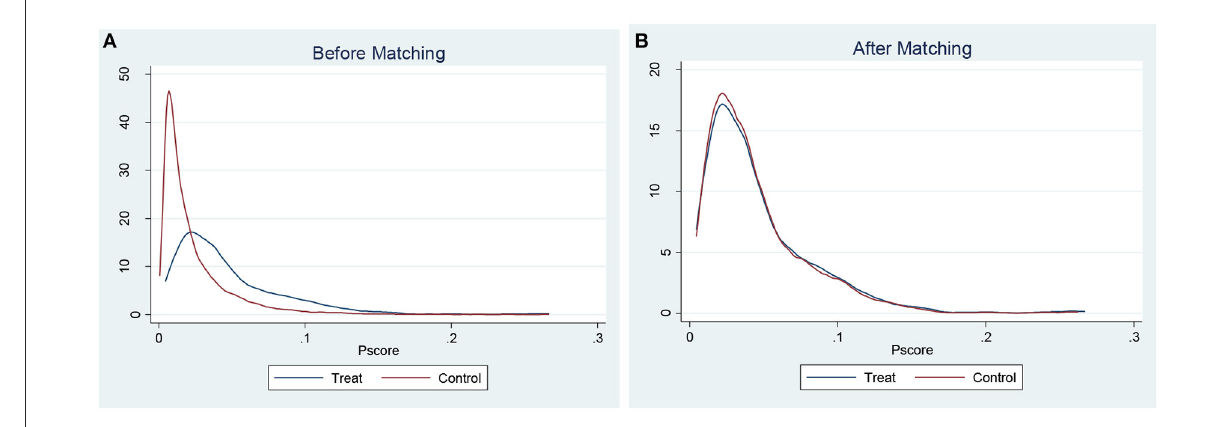
FIGURE2 (A) Propensity score distribution before matching. (B) Propensity score distribution after